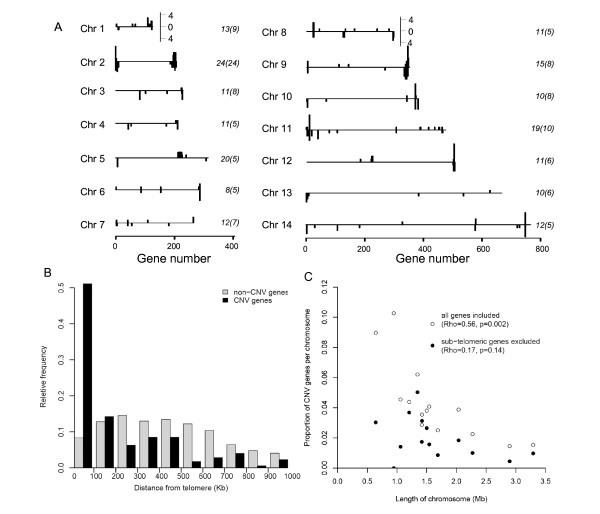
The genomic location of CNVs. (A) Frequencies of CNV for each gene along the genome for each chromosome is shown above the axis for amplifications and below the axis for deletions. Total numbers of CNV genes are given at the left hand side of each chromosome with the number of CNV var, rifin and stevor genes in brackets. (B) Distance to telomeric ends is shown to be significantly decreased in CNV genes (grey bars) in comparison to non-CNV genes (hashed bars). (C) Fraction of a chromosomal gene content classed as a CNV gene declined as number of genes per chromosome increased (open circles), this trend became weaker when the chromosomal portion excluding the sub-telomeric ends was examined (black closed circles). A significant divergence in gradient from 0 was detected only when all genes were analysed together, with multiple-adjusted r2 values indicating a prominent role for chromosome length in predicting its proportion of CNV genes.